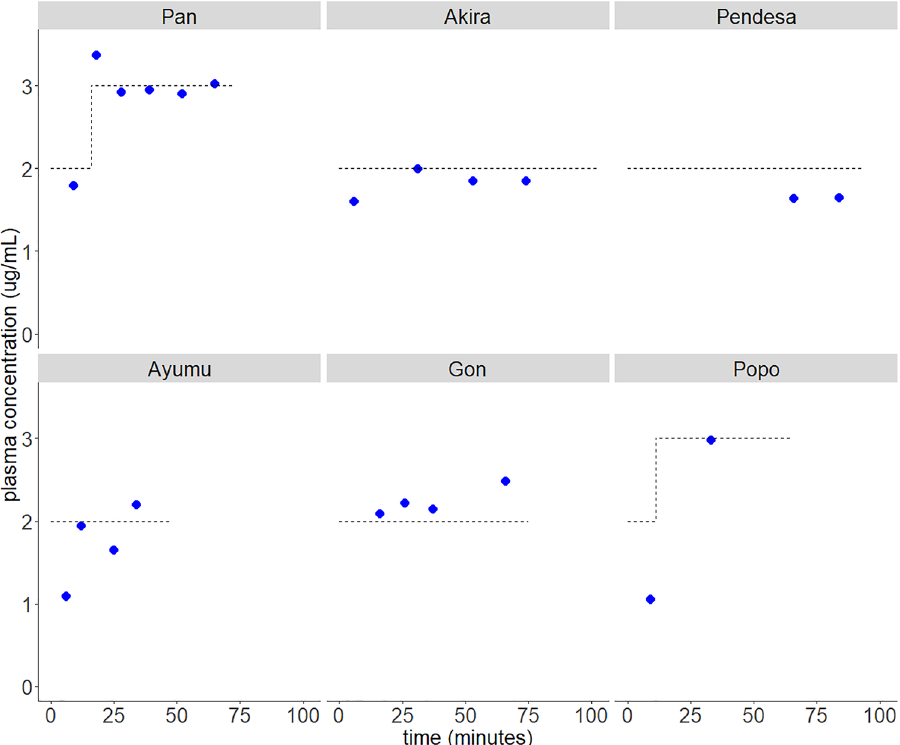
Figure 2. Time course of Cps following propofol TCI in six chimpanzees. A TCI pump programmed with Marsh model was used. Blue circles represent measured Cps and dotted lines indicate target Cps in